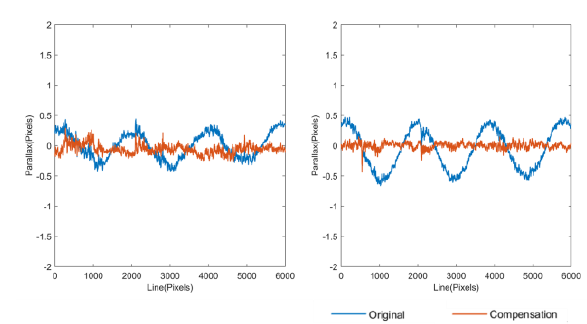
Figure 4 . Comparison of attitude results of CCD1